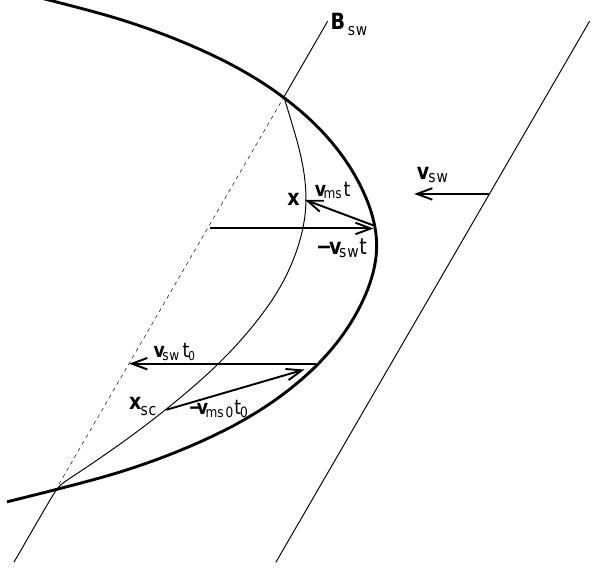
Fig. 3. Schematic demonstrating the geometry used to estimate electron trajectories inside the